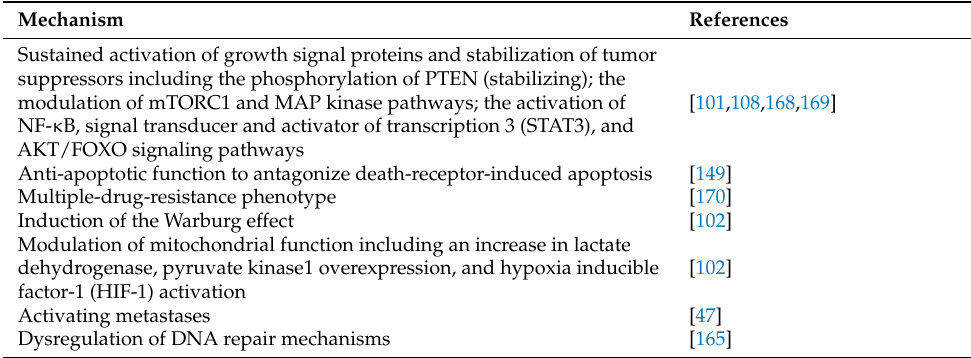
Table 3. The involvement of CK2 in tumorigenic mechanisms.